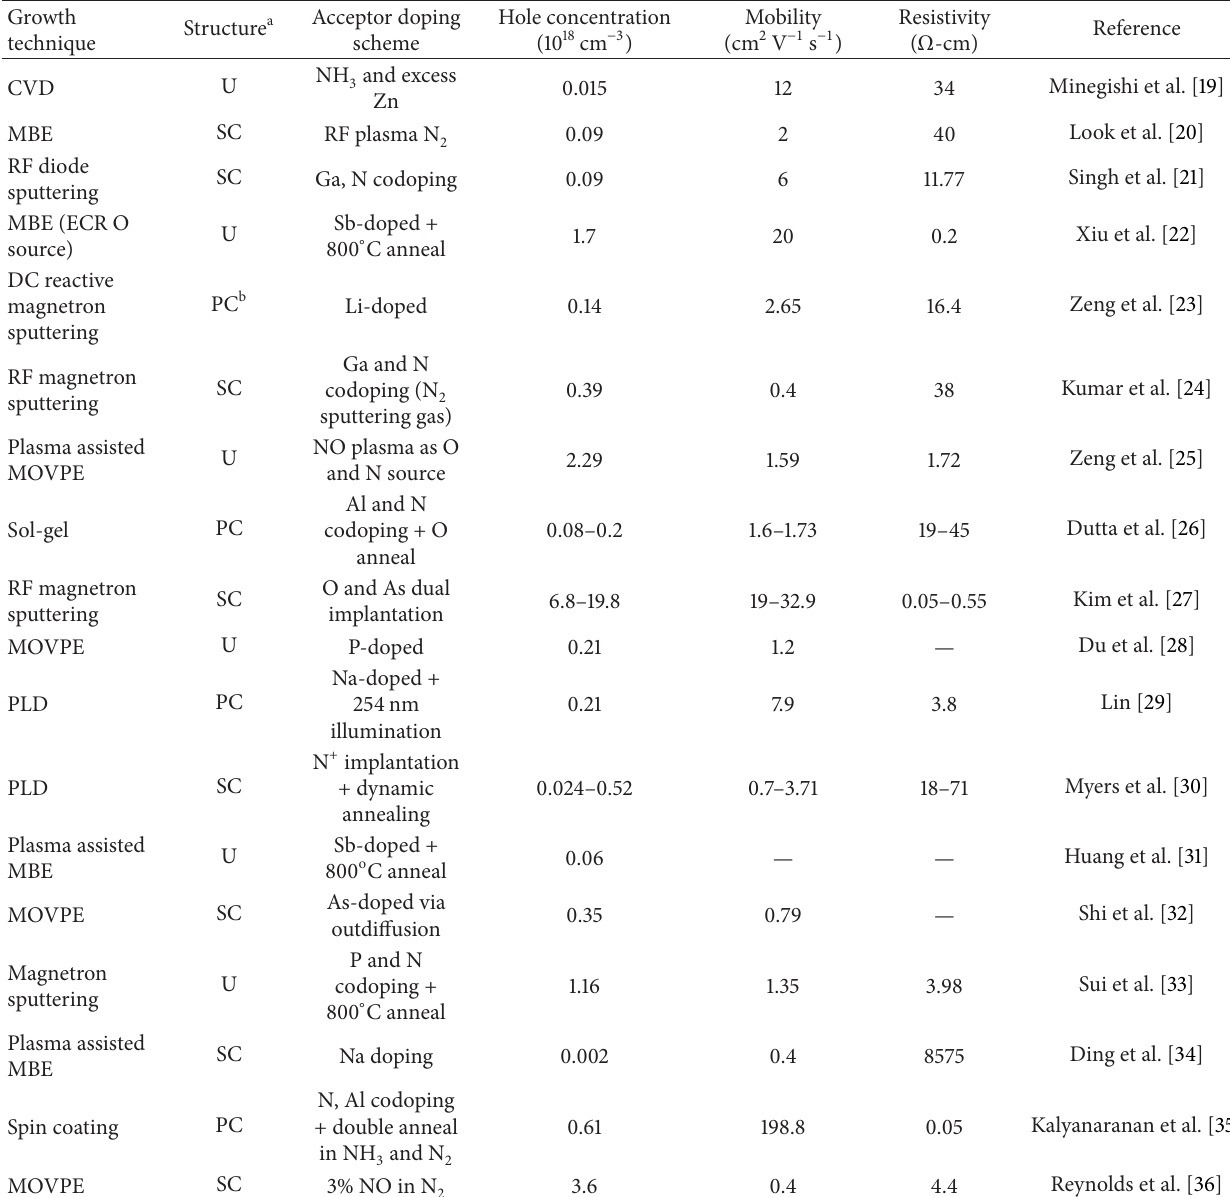
Table 1: Summary of room temperature Hall data for p-type